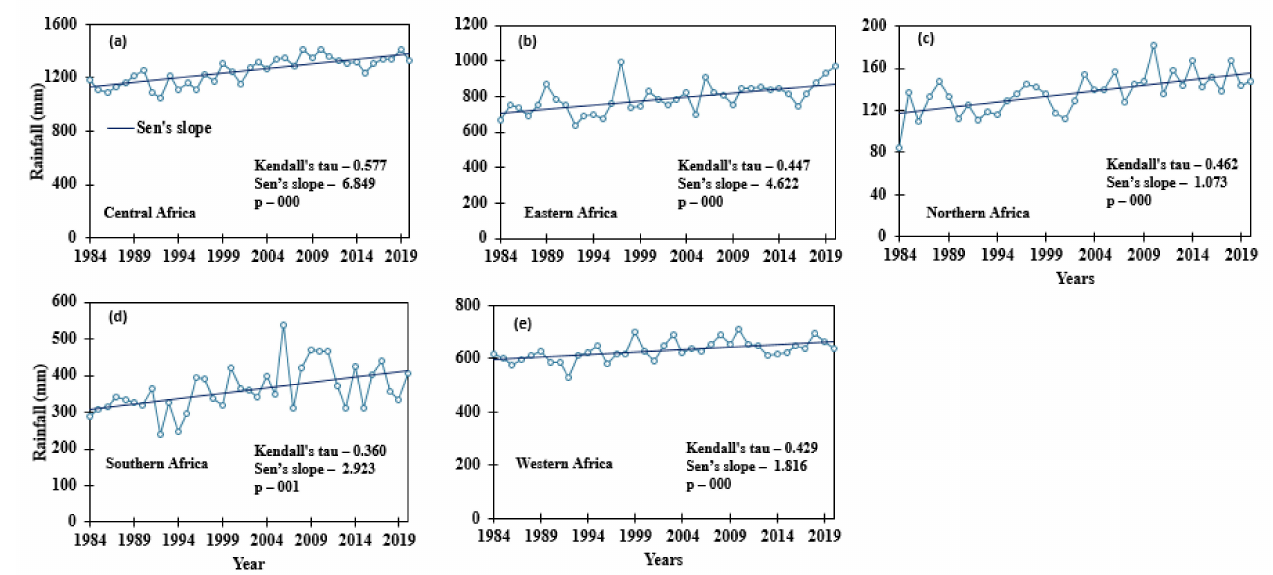
Figure 7. Annual rainfall trend for regions in Africa ( a ) Central region, ( b ) Eastern region, ( c ) Northern region, ( d ) Southern region and ( e ) Western region.